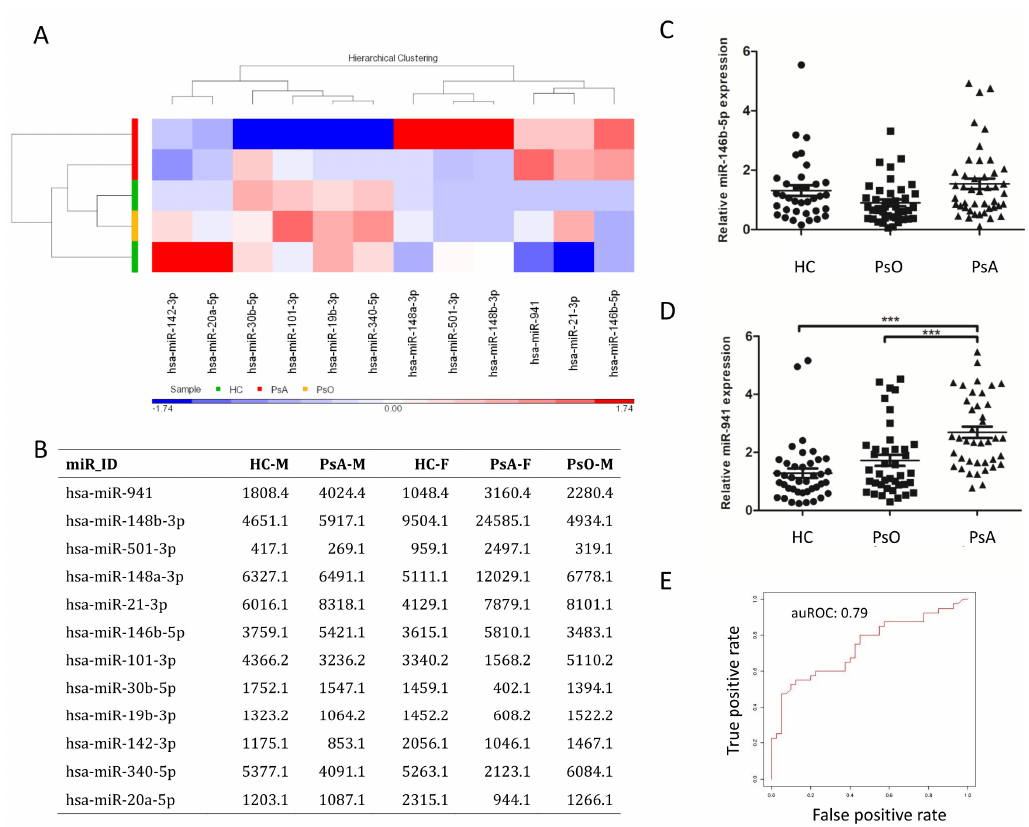
Figure 1. High expression of miR-941 in CD14 + monocytes from PsA patients. ( A ) The RNA samples were analyzed from (1) the healthy control group (HC), including two pooled samples from two males and one female, respectively; (2) the psoriasis group (PsO), including one pooled sample from two males; and (3) the psoriasis arthritis group (PsA), including two samples from two males and one female, respectively. MicroRNAs (miRNAs) with transcript per million (TPM) values more than 1000 in at least one sample and with average expression ratio (normal to disease or disease to normal) more than 1.5 are plotted on the heat map. ( B ) The microRNA expression level was presented in the unit of TPM. ( C , D ) The expression levels of miR-146b-5p and miR-941 were measured in HCs ( n = 40), PsO patients ( n = 40) and PsA patients ( n = 40) by quantitative real-time reverse transcription polymerase chain reaction (qRT-PCR). Patients with PsA showed increased expression of miR-941 in CD14 + monocytes. ( E ) We set training model from miR-941 expression of CD14 + monocytes from patients with PsA, PsO, and HCs using a Support Vector Machine (SVM) learning algorithm. To distinguish PsA from PsO and HC, the value of auROC was 0.79, indicating that miR-941 expression can distinguish PsA patients from PsO and HCs with high accuracy. *** p < 0.001.